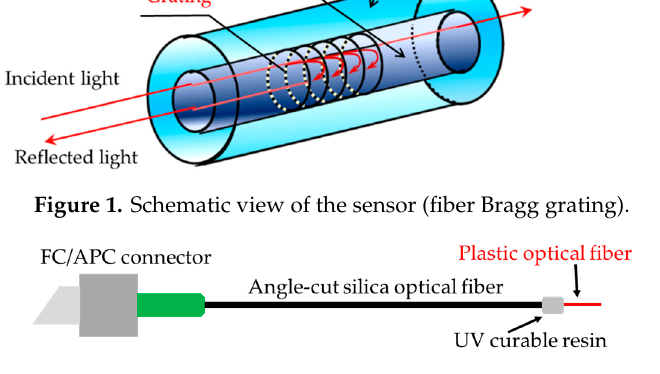
Figure 2. Schematic view of the optical fiber showing the fiber Bragg grating sensor fabricated in plastic optical fiber (POF-FBG) sensor. Table 1. Fiber characteristics of silica-FBG and POF-FBG sensors.